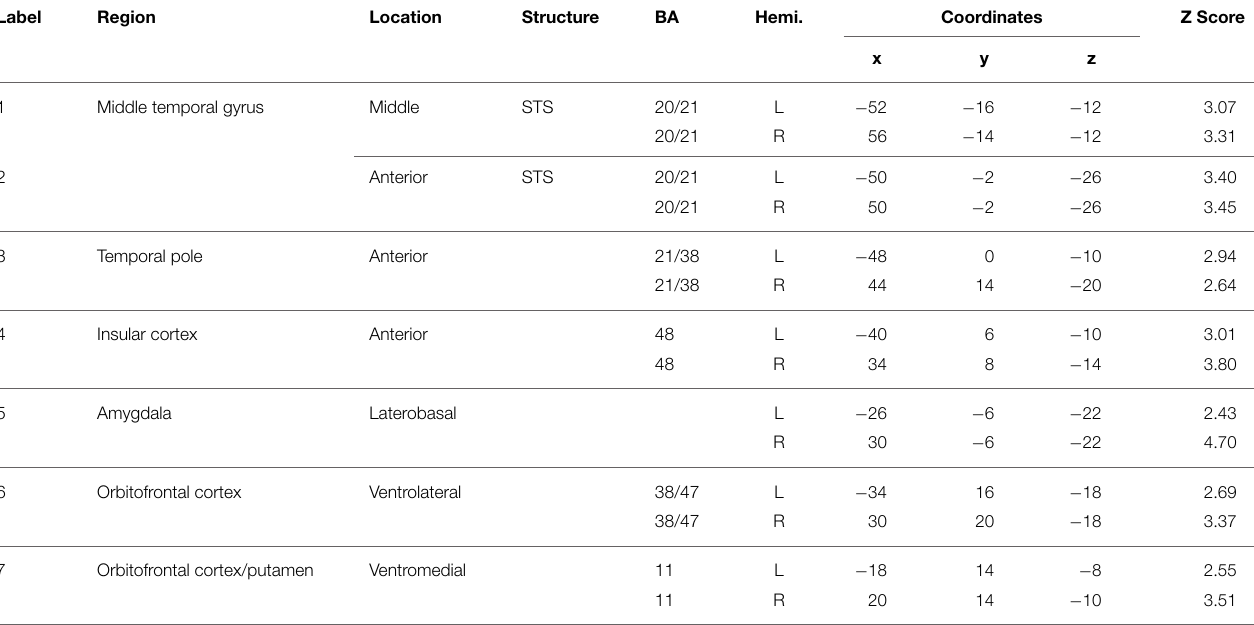
TABLE 3 | Brain regions showing significant BOLD suppression for repeated themes ( p < 0 . 05 , cluster corrected in FSL). Label Region Location Structure BA Hemi. Coordinates